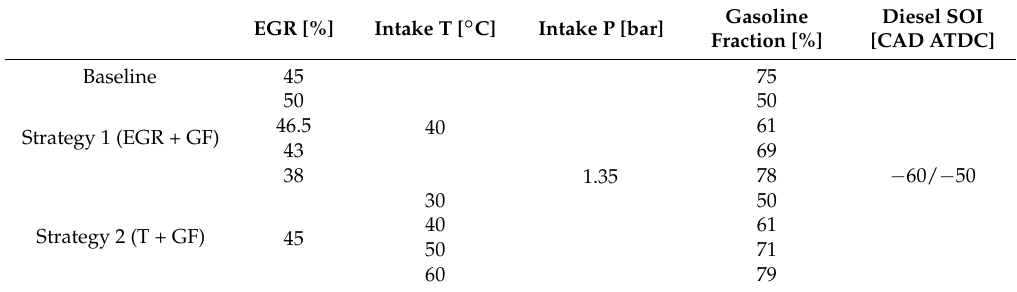
Table 4. Summary of all the tests performed at 7.5 bar to evaluate the two optimization strategies.